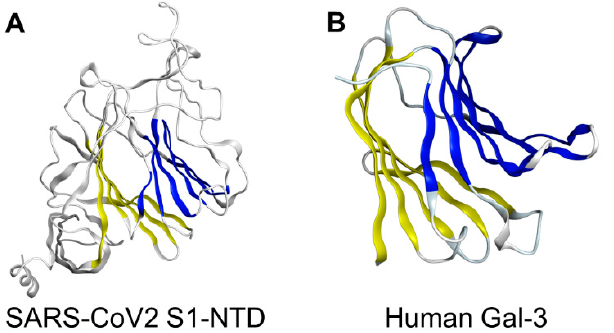
Figure 3. Structural similarities of SARS-CoV2 S1-NTD and human Gal-3. The structural topologies of the ( A ) SARS-CoV2 S1-NTD (PDB ID: 6VXX) and ( B ) human Gal-3 (PDB ID: 1KJR) are shown as schematic illustrations, where corresponding structures are depicted with the same colour and sialic acid binding site in SARS-CoV2 S1-NTD is depicted in red.